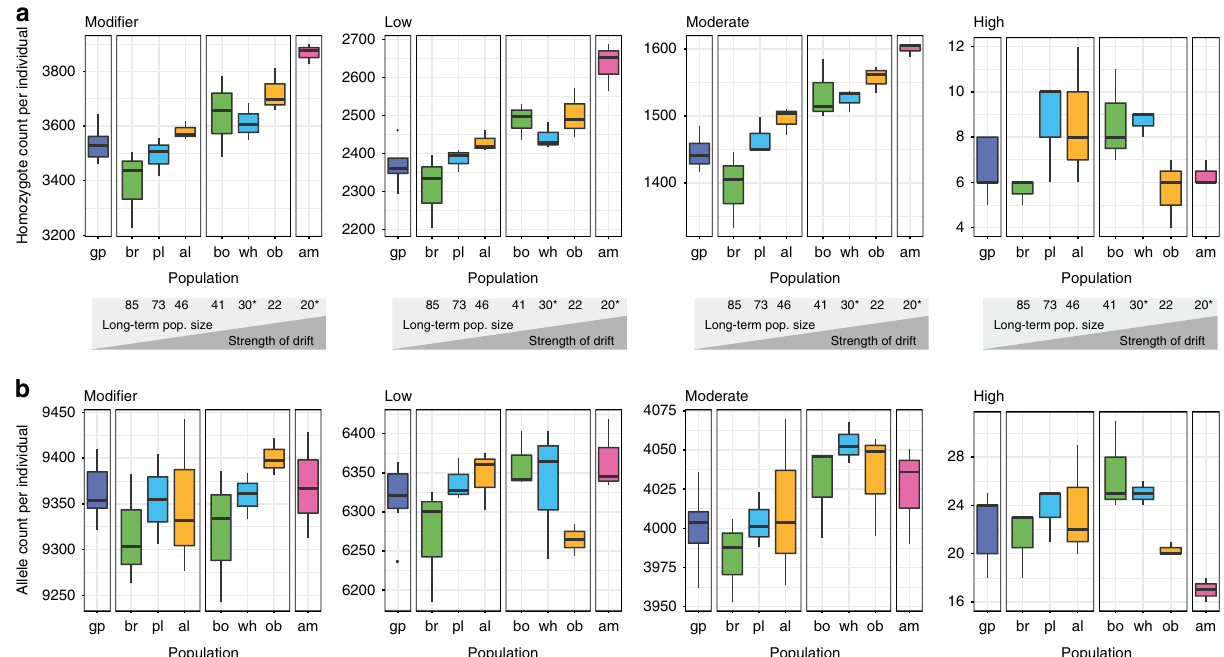
Fig. 4 Impact of the recolonization on the individual mutation load. a Homozygote counts and ( b ) allele counts per individual for each Alpine ibex population. The schematic between A and B indicates the harmonic mean of the census size of each population, which is inversely correlated with the strength of drift. * Estimated numbers. Colors associate founder and descendant populations (see also Fig. 3a). Box plot elements are de fi ned as in Fig. 1. Source data are provided as a Source Data fi